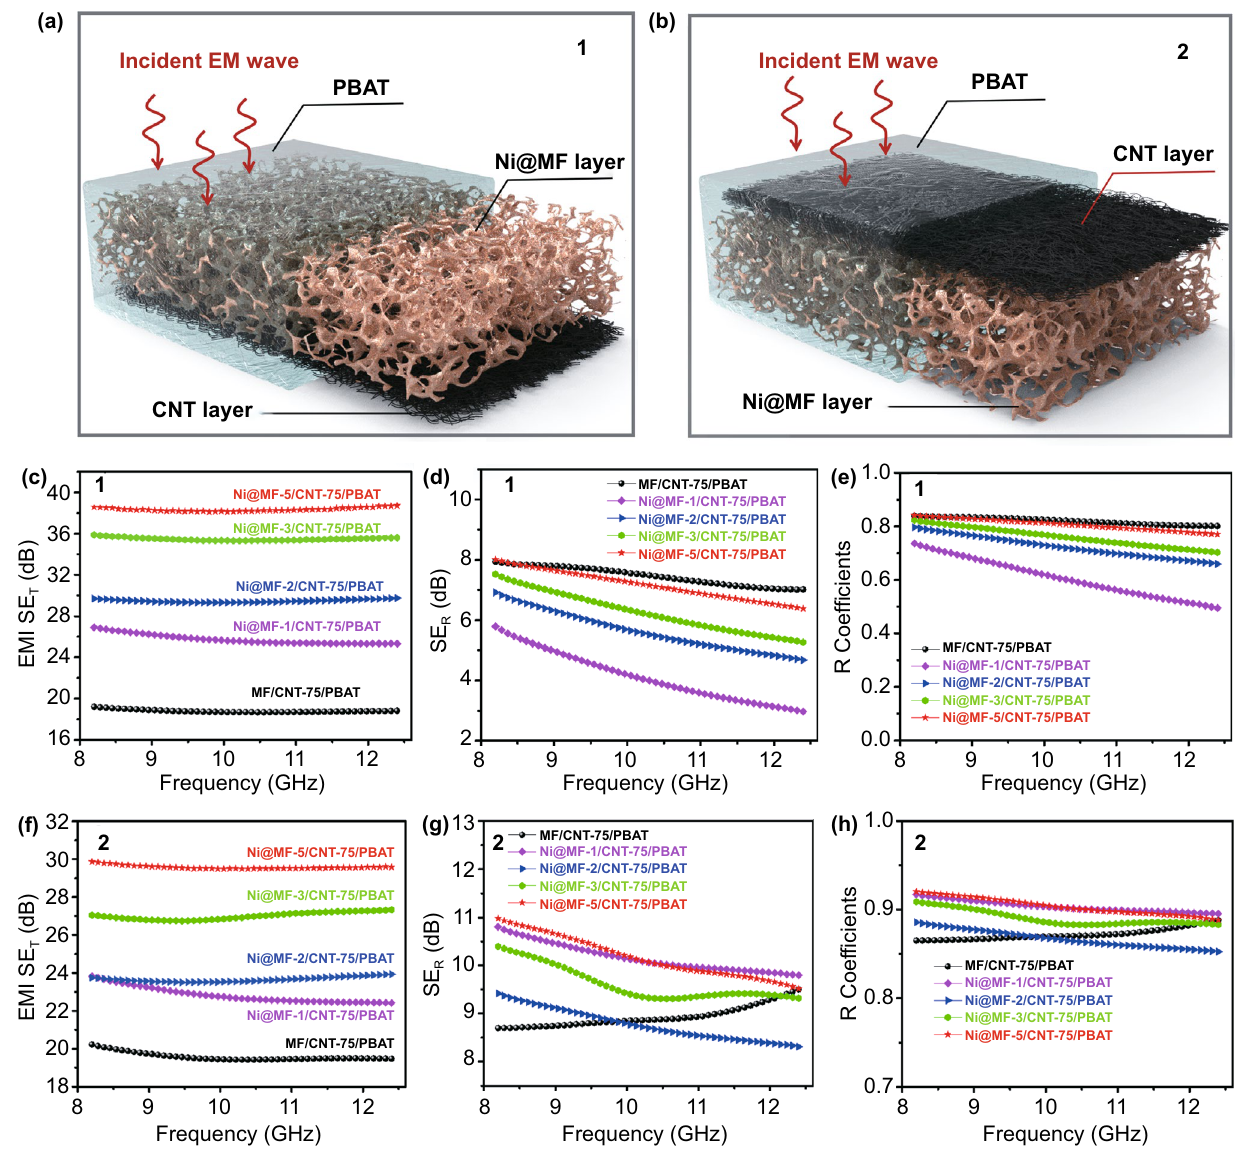
Fig. 3 Directional EMI shielding performances. a Schematic for experiment 1, the incident EM wave from Ni@MF layer. b Schematic for experiment 2, the incident EM wave from CNT layer. c EMI SE T , d SE R , and e R coefficients in X-band for Ni@MF/CNT-75/PBAT composites, when the EM wave is incident from Ni@MF layer (experiment 1). f EMI SE T , g SE R , and h R coefficients in X-band for Ni@MF/CNT-75/PBAT composites, when the EM wave is incident from CNT layer (experiment